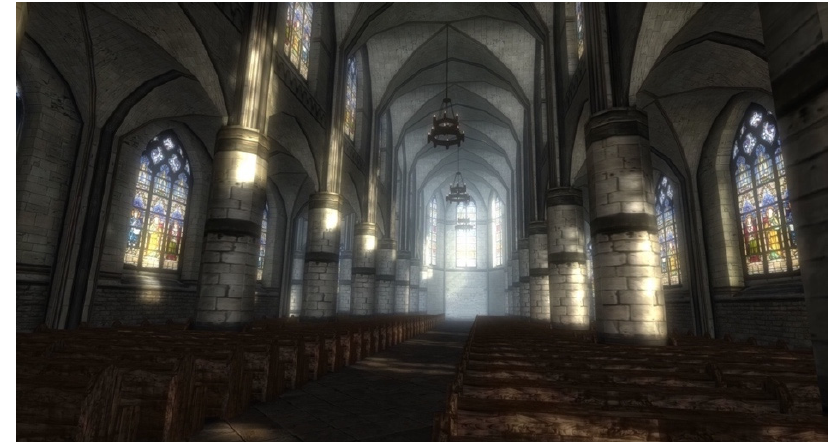
Figure 6. Building type 1 (BT1) church digital model: front interior view.